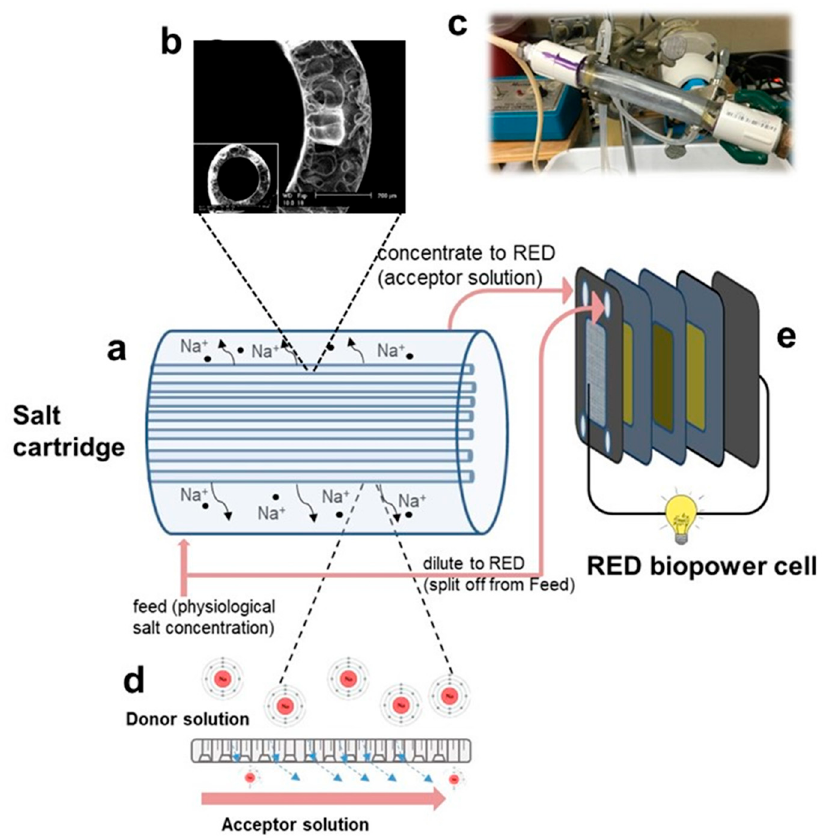
Figure 1. Schematic representation of the salt cartridge-RED power cell set up: ( a ) schematic drawing of the cartridge illustrating ion movement, ( b ) SEM image of the hollow-fiber membranes used in the cartridge, ( c ) picture of salt cartridge, ( d ) a schematic close up of the transport of Na + ions through the hollow-fiber membranes, ( e ) schematic drawing of the RED biopower cell.